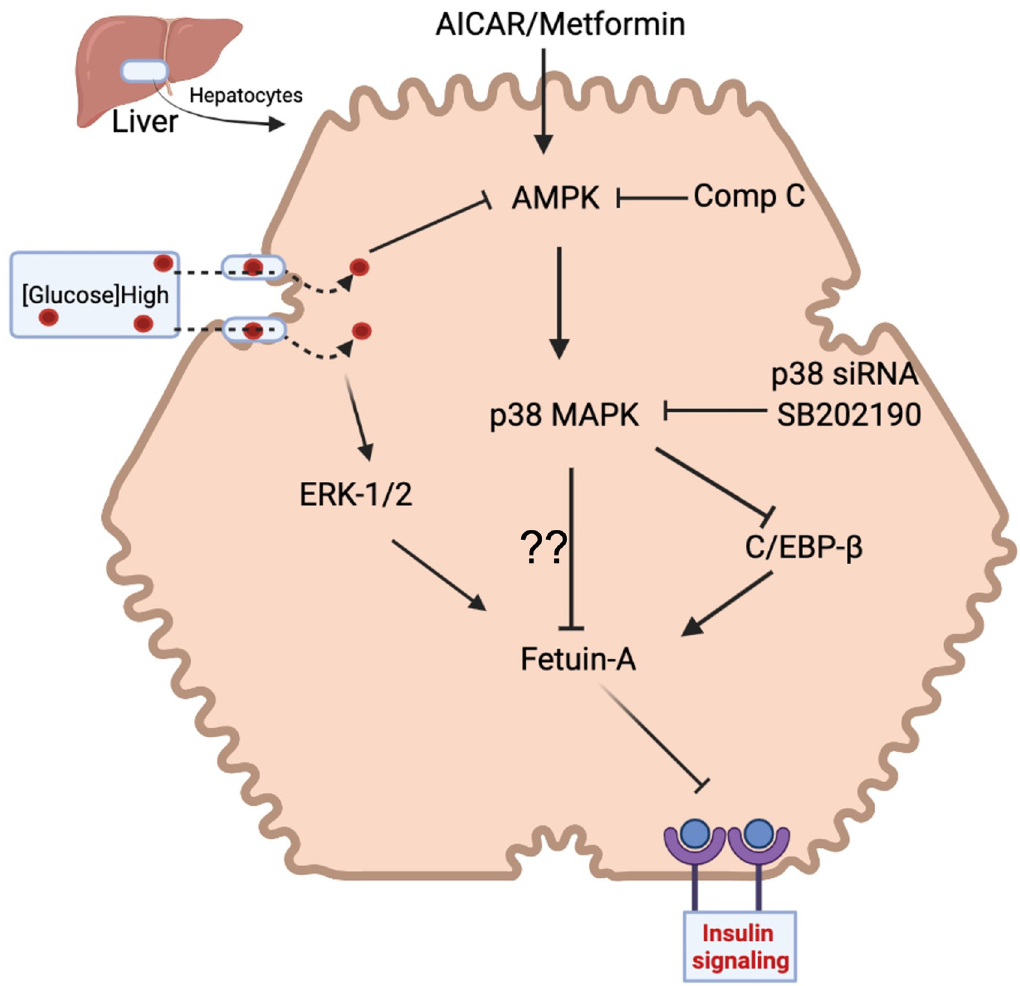
Fig 6. Working model for AICAR-mediated regulation of hepatic Fet-A expression. Metformin or AICAR increases the phosphorylation of AMPK, which activates p38 MAPK. As a result, AMPK-p38MAPK signaling suppresses high-glucose induced Fet-A expression either by increasing proteasomal degradation and/or by decreasing hepatic expression of C/EBP beta.